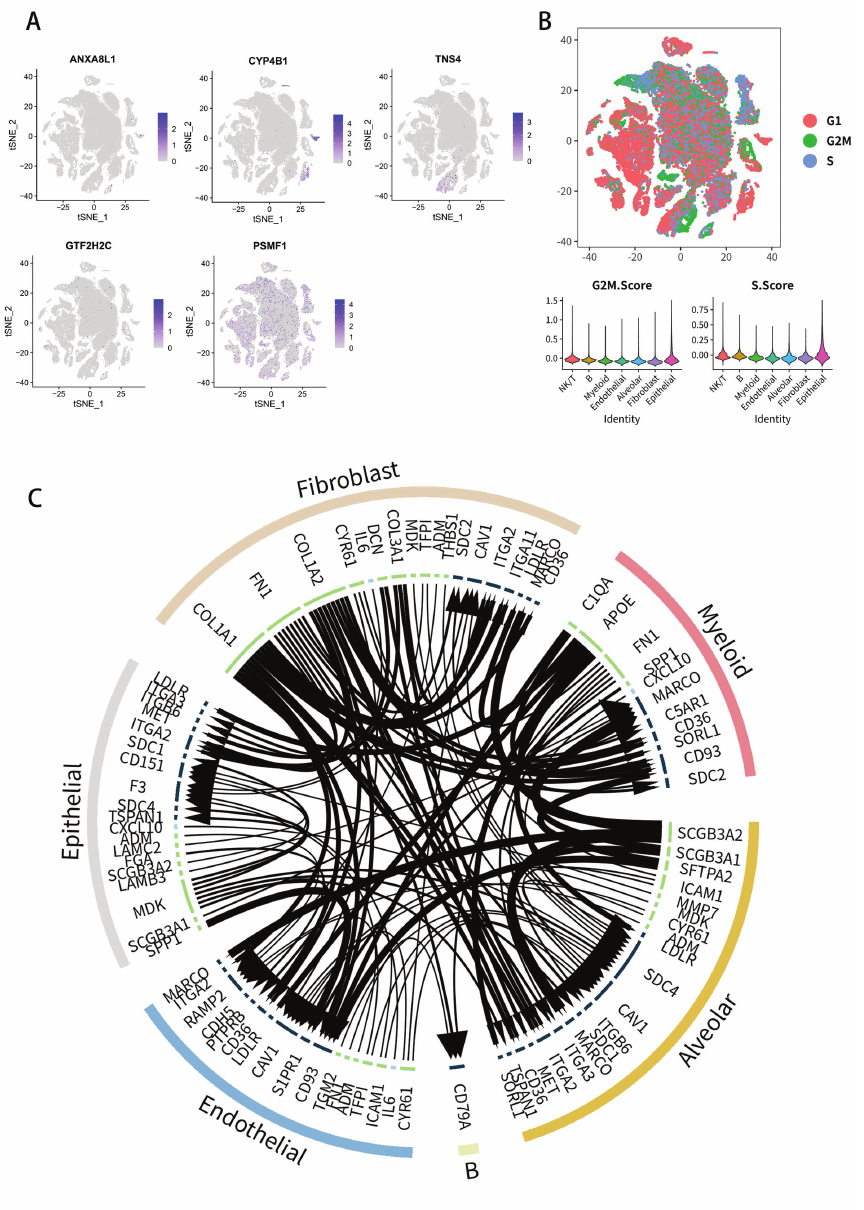
Figure 9. Distribution of five key PDEEs in seven cell types in NSCLC. ( A ) Expressions of five key PDEEs (ANXA8L1, CYP4B1, GTF2H2C, PSMF1, and TNS4) in each cluster. ( B ) Cell cycle of each cell. ( C ) ligand-receptor plot for pairs of ligand and receptor among the seven cell types. NSCLC, Non-small cell lung cancer; PDEEs, prognostic differentially expressed